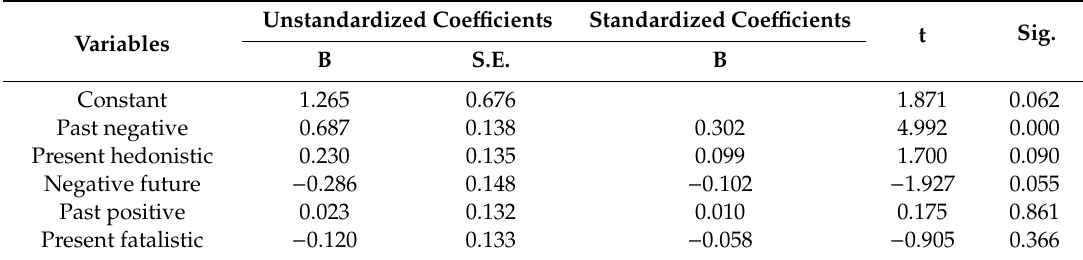
Table 4. Personality Predictors of cynicism.